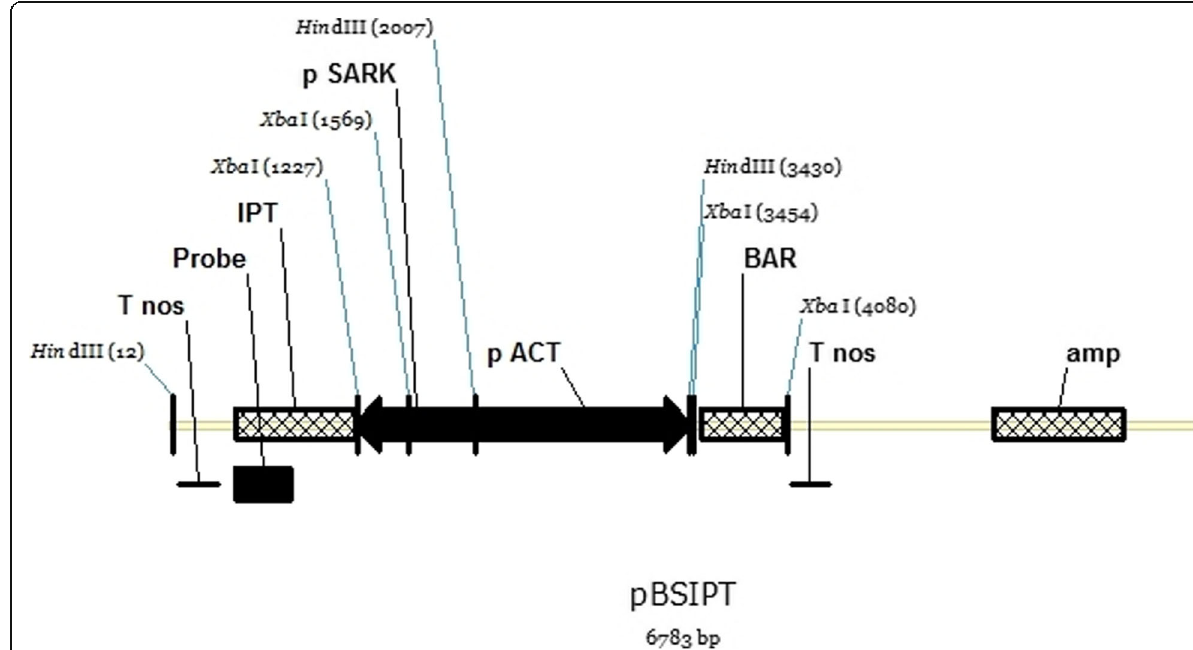
Fig. 1 Schematic representation of the plasmid used for the genetic transformation of wheat by biolistics. IPT , isopentenyl transferase; p SARK , senescence-associated receptor-like kinase promoter; TNOS , nopaline synthase terminator; BAR , phosphinothricin acetyltransferase; ACT1 ,